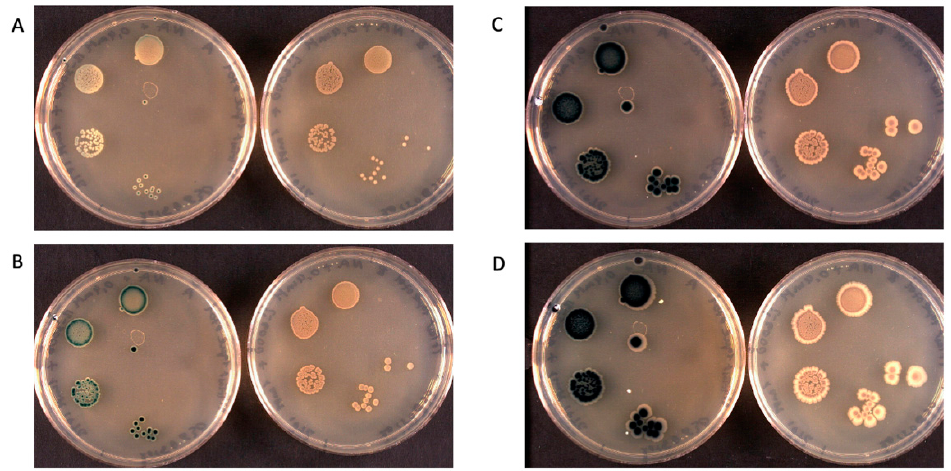
Figure 6. Test on agar plates (nutrient agar, 5 g/L peptone, 5 g/L NaCl, 2 g/L yeast extract, 1 g/L meat extract, 15 g/L agar, pH 7.4). Inducer for β -galactosidase: IPTG, 1 mM. Test strain: E. coli ATCC 25922 ( β -galactosidase positive). Bacteria were incubated in presence of indoxyl substrate 24 (left) or 25 (right) for 16 h ( A ), 24 h ( B ), 48 h ( C ), 6 days ( D ). Pictures kindly supplied by Dr Julian Ihssen, Biosynth Carbosynth.